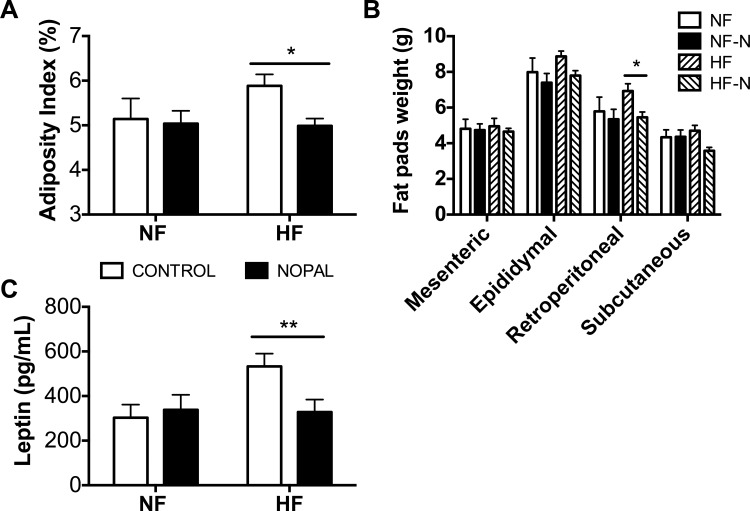
Effect of nopal consumption on adiposity and serum leptin levels.A) Adiposity index. B) Fat pad mass. C) Serum leptin levels. Data are presented as mean ± SEM (n = 5–14 per group). Significance was set at P < 0.05.